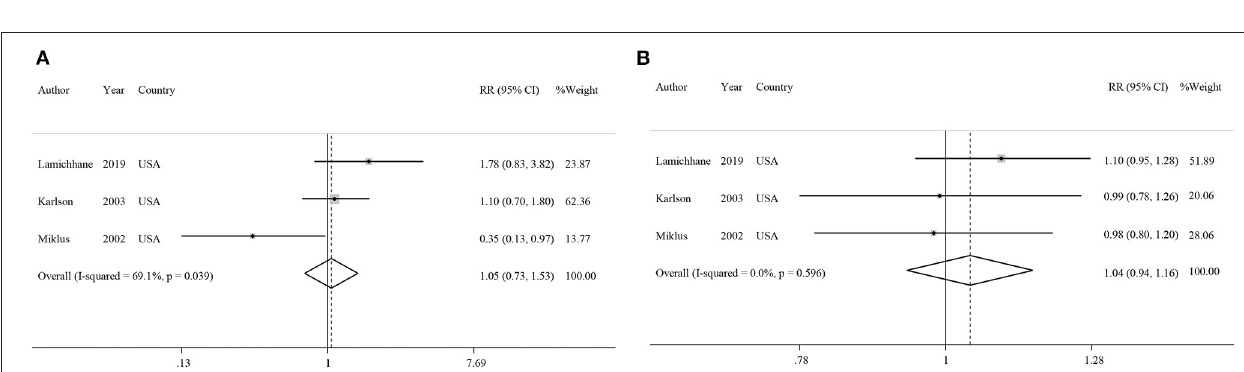
lowest category of tea intake showed no significant association between tea intake and risk of RA (RR: 1.05; 95% CI: 0.73–1.53; Figure 5A ), with significant heterogeneity among the studies ( I 2 = 69.1%; P = 0.03). Furthermore, sensitivity analysis found